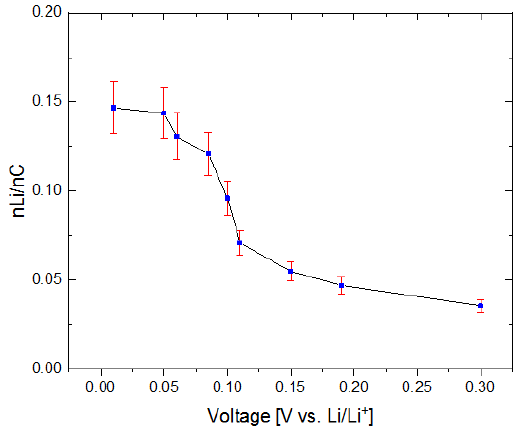
Figure 3. Quantitative ratio of lithium to carbon content measured by inductively coupled plasma–optical emission spectrometry (ICP-OES) as a function of voltage.